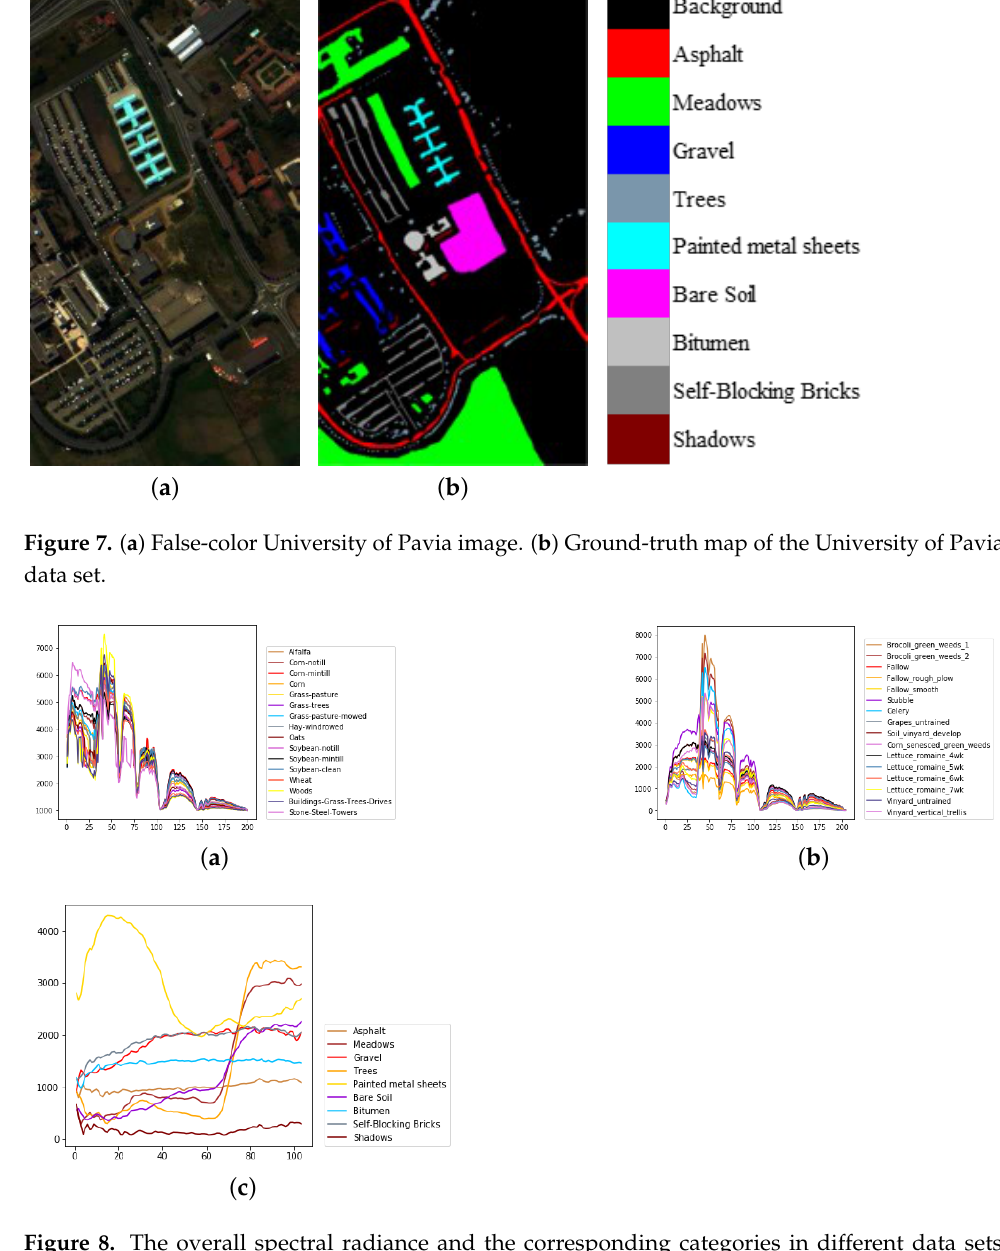
Figure 8. The overall spectral radiance and the corresponding categories in different data